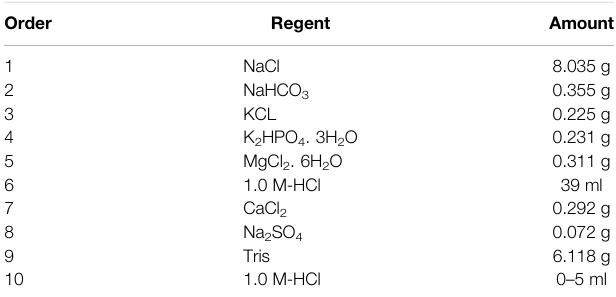
TABLE 1 | Order and amount of reagents used for the preparation of 1000 ml SBF. Order Regent Amount